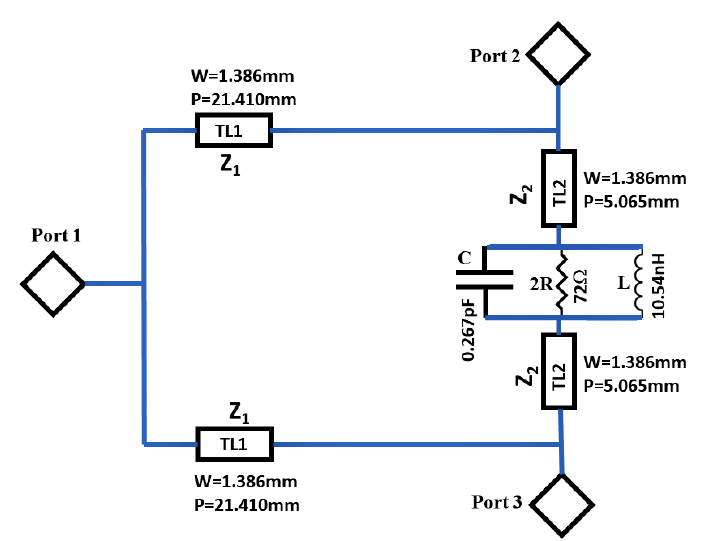
Figure 10. Circuit schematic analysis of WPD designed at 3 GHz with physical dimensions and equivalent DGS